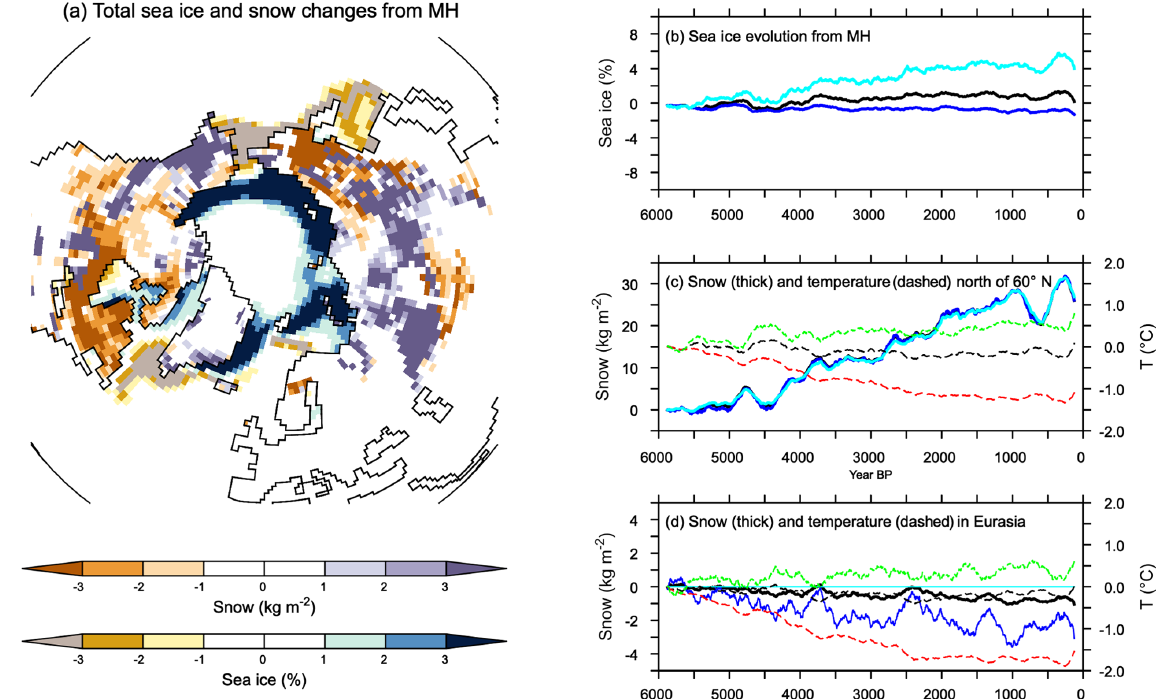
Figure 8. (a) Total change in snow cover (kgm − 2 ) and sea-ice fraction (%) integrated over the last 6000 years, and evolution from the Mid- Holocene of annual mean maximum summer and minimum winter values for (b) sea-ice averages over the Northern Hemisphere, (c) snow (solid lines) and 2m air temperature (dotted lines) averaged for all regions north of 60 ◦ N, and (d) snow and 2m air temperature over Eurasia. In (b, c) , and (d) black, dark blue and light blue stand, respectively, for the annual mean, maximum, and minimum annual monthly values for sea-ice or snow cover, and black, green, and red stand for annual mean, minimum, and maximum air